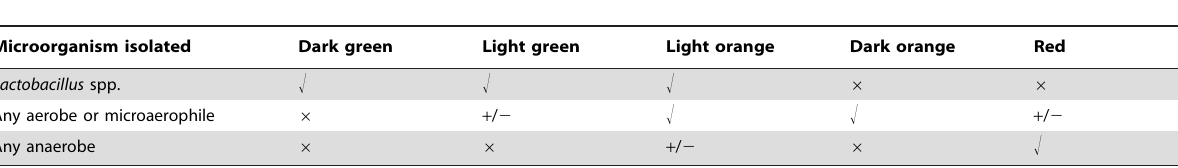
Table 3. Heat map key to shading based on microbial composition within the sample.